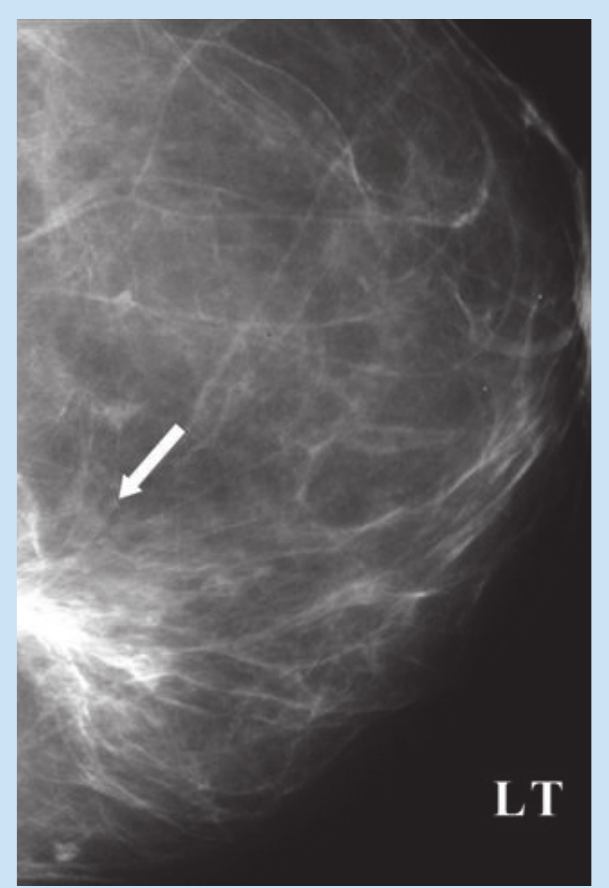
Fig. 3. MG. Spiculated mass in the lower lateral quadrant left breast (arrow). No translucent centre. No calcifications.